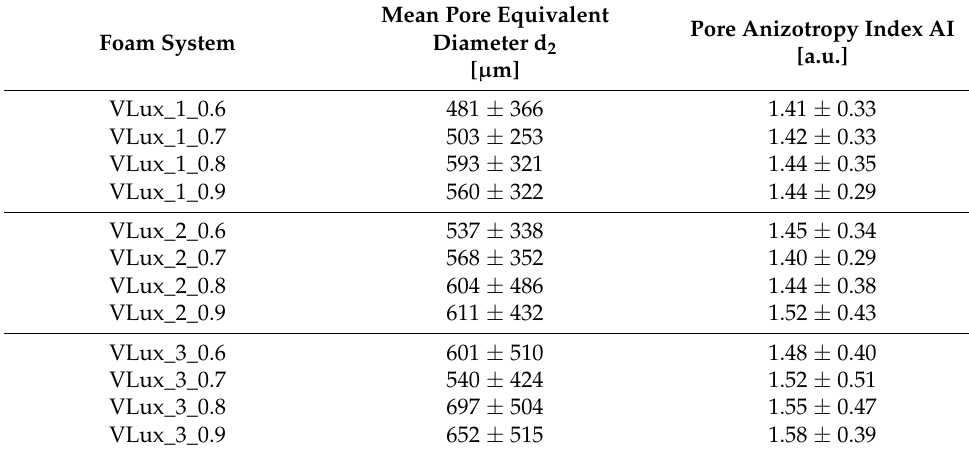
Figure 7. SEM images of manufactured foams with their water content and INCO index. Table 4. Results of quantitative SEM images